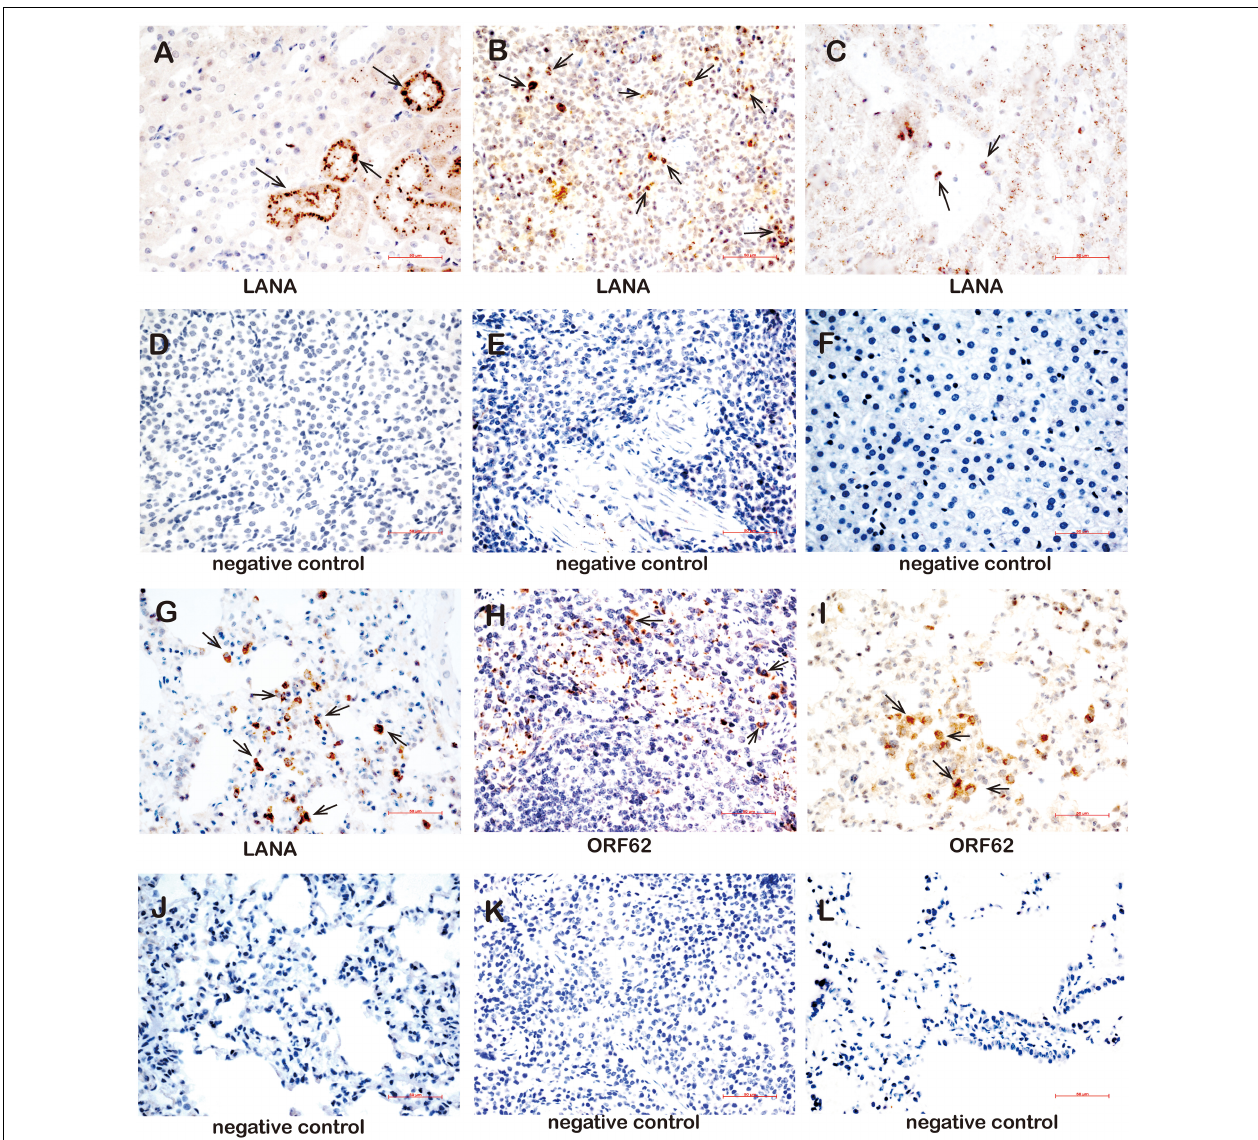
FIGURE 7 | Immunohistochemistry detection in tissues of rKSHV.219-infected tree shrews. (A) The kidney epithelial cells of the TS3 kidney were nuclear staining positive for LANA at 119 dpi. (B) The lymphocytes of the TS4 spleen were nuclear staining positive for LANA at 91 dpi. (C) Hepatocytes of TS3 liver were nuclear staining positive for LANA at 119 dpi. Panels (D–F) were LANA negative control of kidney, spleen, and liver, respectively. (G) The alveolar tissues and lung epithelial cells of TS11 lung were nuclear staining positive for LANA at 14 dpi. (H) The lymphocytes of the TS3 spleen were cytoplasm staining positive for ORF62 at 119 dpi. (I) The alveolar tissues and lung epithelial cells of TS7 lung were cytoplasm staining positive for ORF62 at 56 dpi. (J) was LANA negative control of lung. Panels (K,L) were ORF62 negative control of spleen and lung, respectively. Original magnification, 40 × .